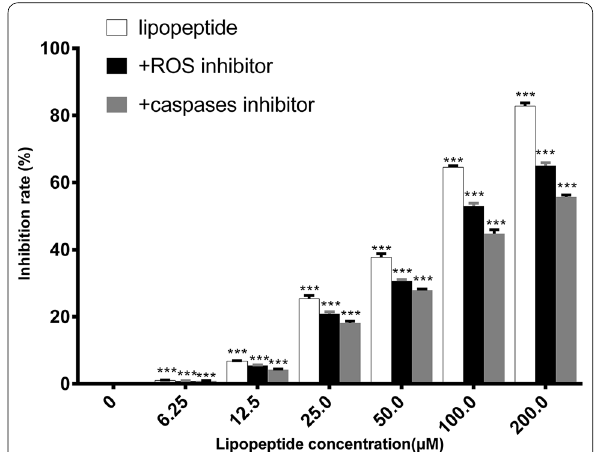
Fig. 7 Influence of ROS inhibitor and caspases inhibitor on the inhibi- tory effect of lipopeptides on the viability of K562 cells. The data were obtained after the cells had been treated with lipopeptides for 48 h. When caspase enzyme activity and ROS accumulation were inhibited, the inhibition rate of K562 cells was significantly